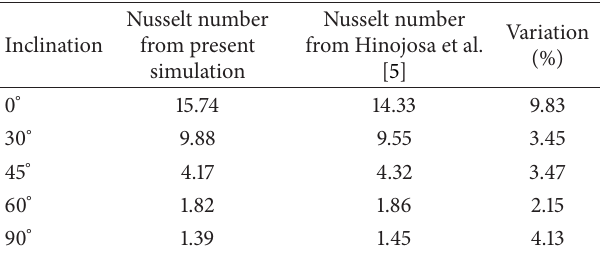
Table 1: Comparison of the Nusselt number values obtained from the present simulation and those reported by Hinojosa et al. [5] for Ra 𝐻 = 1 × 10 6 at different